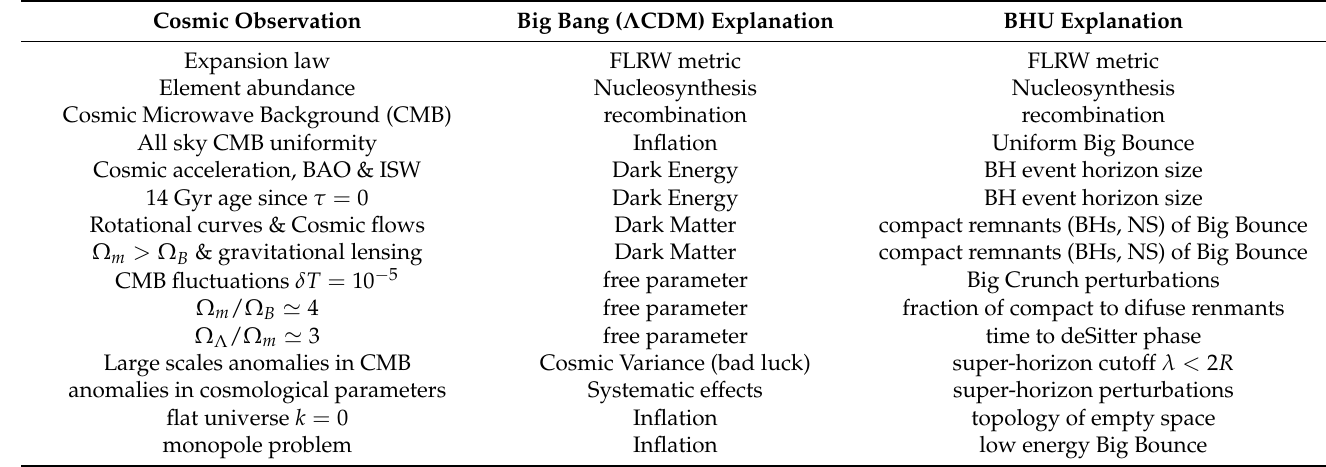
Table 1. Model comparison. Observations that require